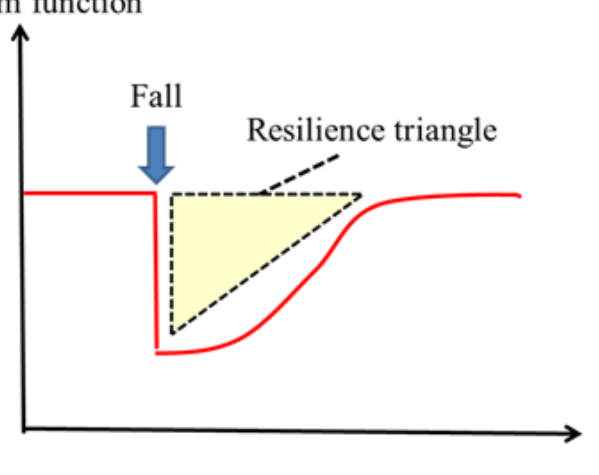
Figure 6. Resilience curve.